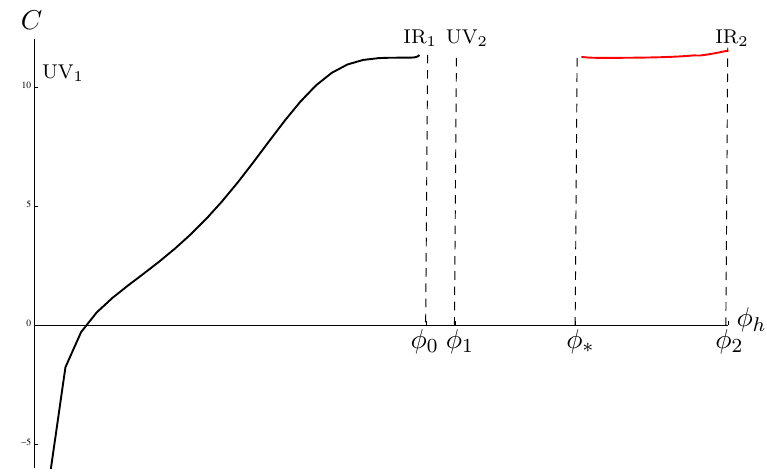
Figure 9 . The (dimensionless) vev parameter C as a function of the scalar (cid:12)eld horizon value (cid:30) h for black holes connecting to UV 1 . As the horizon approaches the UV (cid:12)xed point at (cid:30) = 0, the parameter C ! (cid:0)1